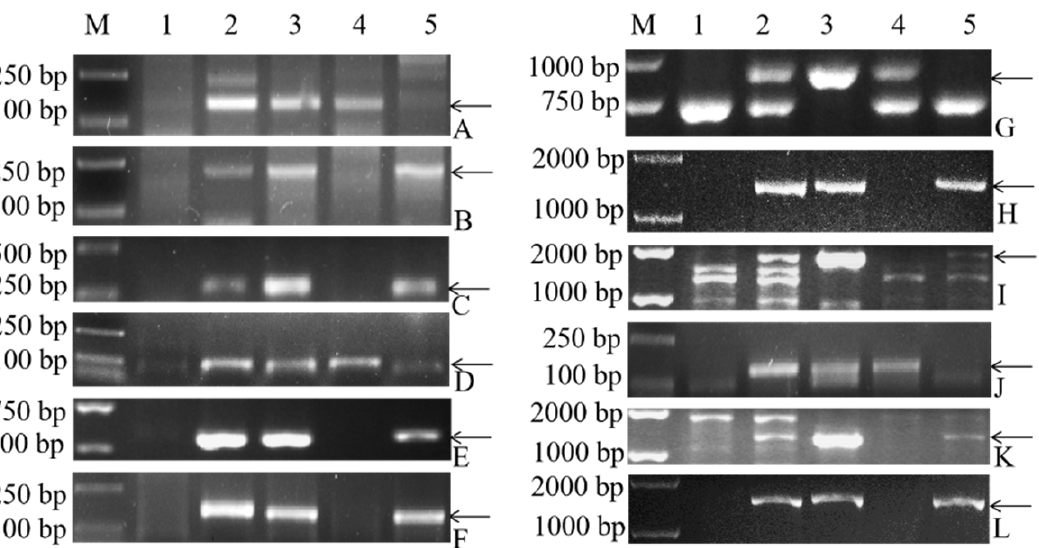
Figure 4. PCR patterns obtained with the primers 3V#3-1–3V#3-12 for wheat– D. villosum derivatives and their parents. M is Trans2K plus DNA marker, 1–5 are CS, CD-3, D. villosum accession PI 491576, 22-12 and 24-20, respectively. ( A – L ) Markers 3V#3-1–3V#3-12. The arrows showe D. villosum -specific bands.